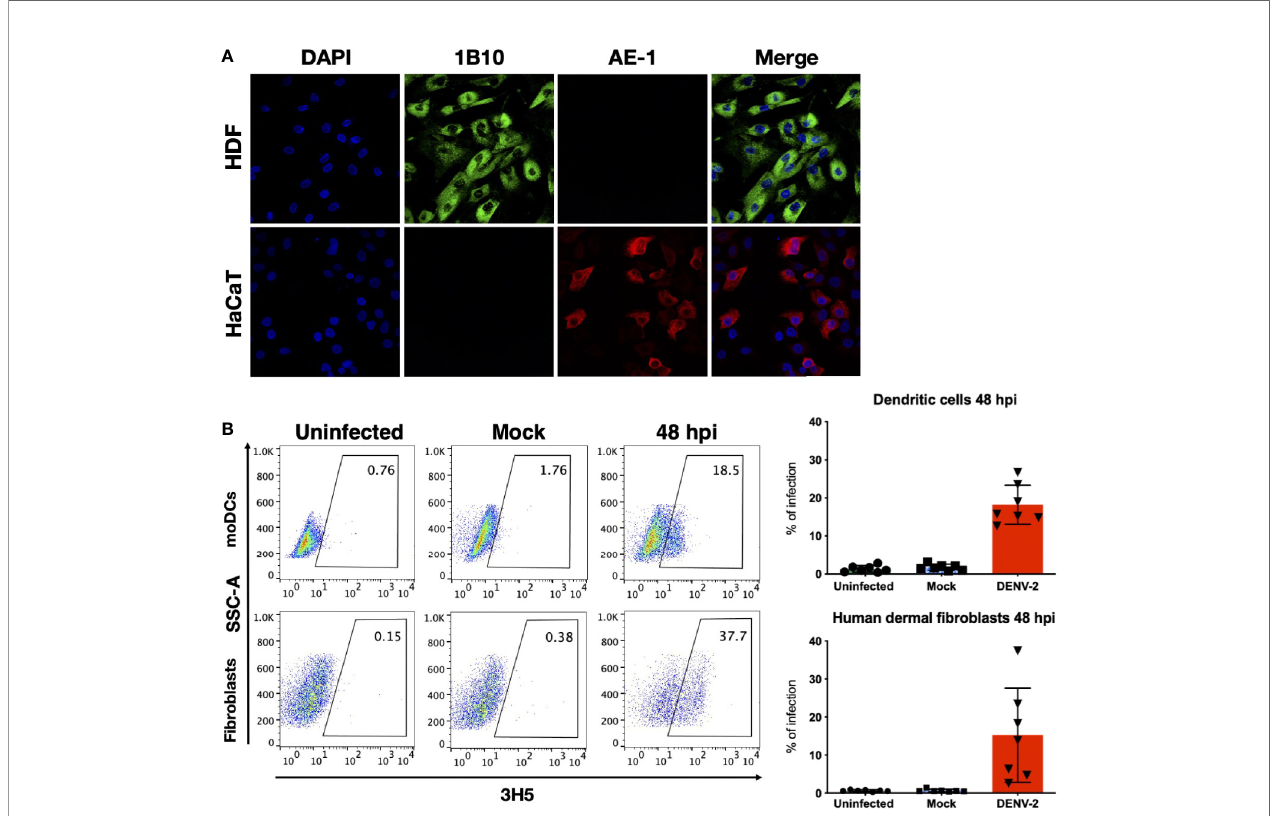
FIGURE 1 | Characterization of HDF and permissiveness to DENV infection in primary HDF and moDC. (A) Immuno fl uorescence staining of HDF and HaCaT cells with 1B10 (green) and AE-1 (red) antibodies that label fi broblasts and keratinocytes, respectively. (B) Con fl uent monolayers of fi broblasts or moDCs were infected at a multiplicity of 5 and 2, respectively, for 48 hours. Subsequently, fl ow cytometry staining was performed to determine the percentage of infected cells based on the expression of the Envelope viral antigen. Error bars indicate the standard deviations for the three independent experiments of each donor, n =